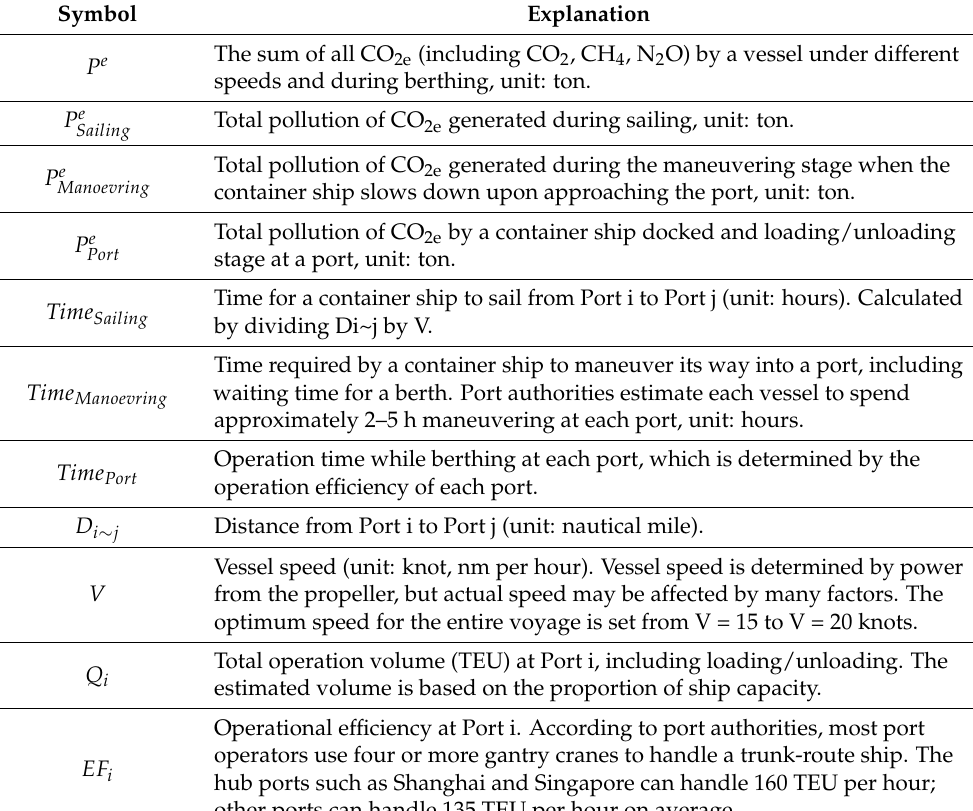
Table 2. Symbols and